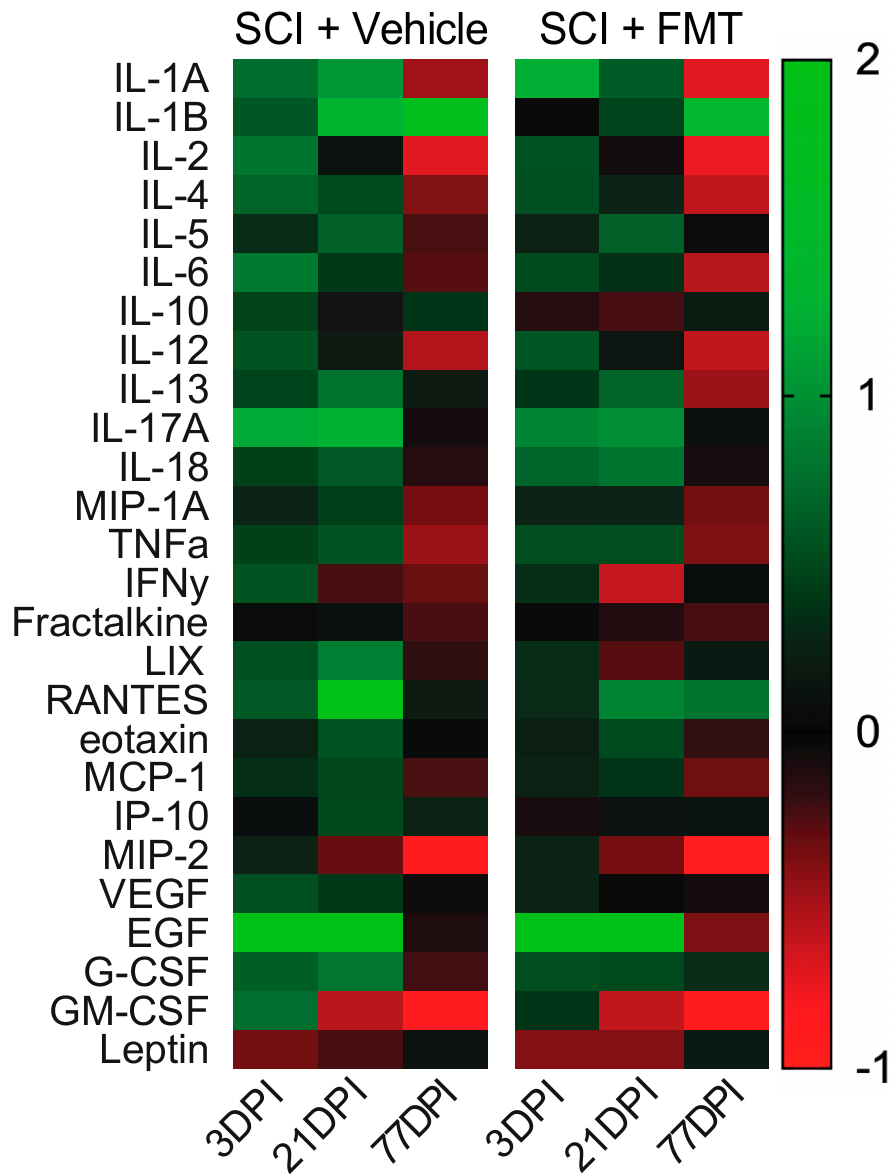
Figure 7. Heatmap of plasma markers over time following SCI. Plasma markers (cytokines, chemokines, growth factors, glycoproteins and hormones) were expressed as a change from baseline values and plotted over time (positive numbers represent an increase from baseline values and negative numbers represent a decrease from baseline values). Values above 2 were set at 2 for visualization purposes (RANTES and EGF were affected).